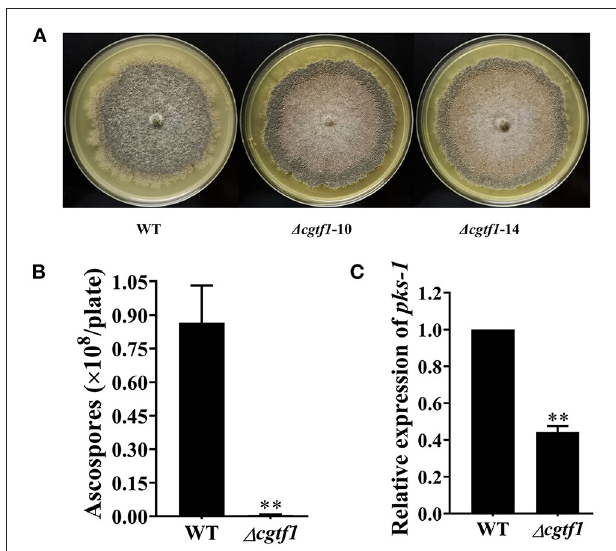
FIGURE 2 | CgTF1 deletion resulted in a severe defect in ascospore development. (A) CgTF1 deletion resulted in delayed perithecium formation. The wild-type (WT) was inoculated in PDA medium, and mutants ∆ cgtf1-10 and ∆ cgtf1-14 were inoculated in PDA medium supplemented with 100 mg/L hygromycin B. These plates were unanimously incubated at 28 ◦ C for 15 days. (B) CgTF1 deletion resulted in a severe defect in sporulation. The indicated strains ∆ cgtf1 and the wild-type were inoculated in the PDA plate and incubated at 28 ◦ C for 30 days. (C) CgTF1 deletion resulted in downregulation of pks-1 transcription. Transcript levels of the pks-1 were detected by qRT-PCR in the WT and ∆ cgtf1 strains. Transcripts of pks-1 was normalized against ACTIN . All experiments were performed in triplicate. There is significantly difference between the WT and CgTF1 null mutants as indicated by two asterisks ( p -value < 0.01, with T -test